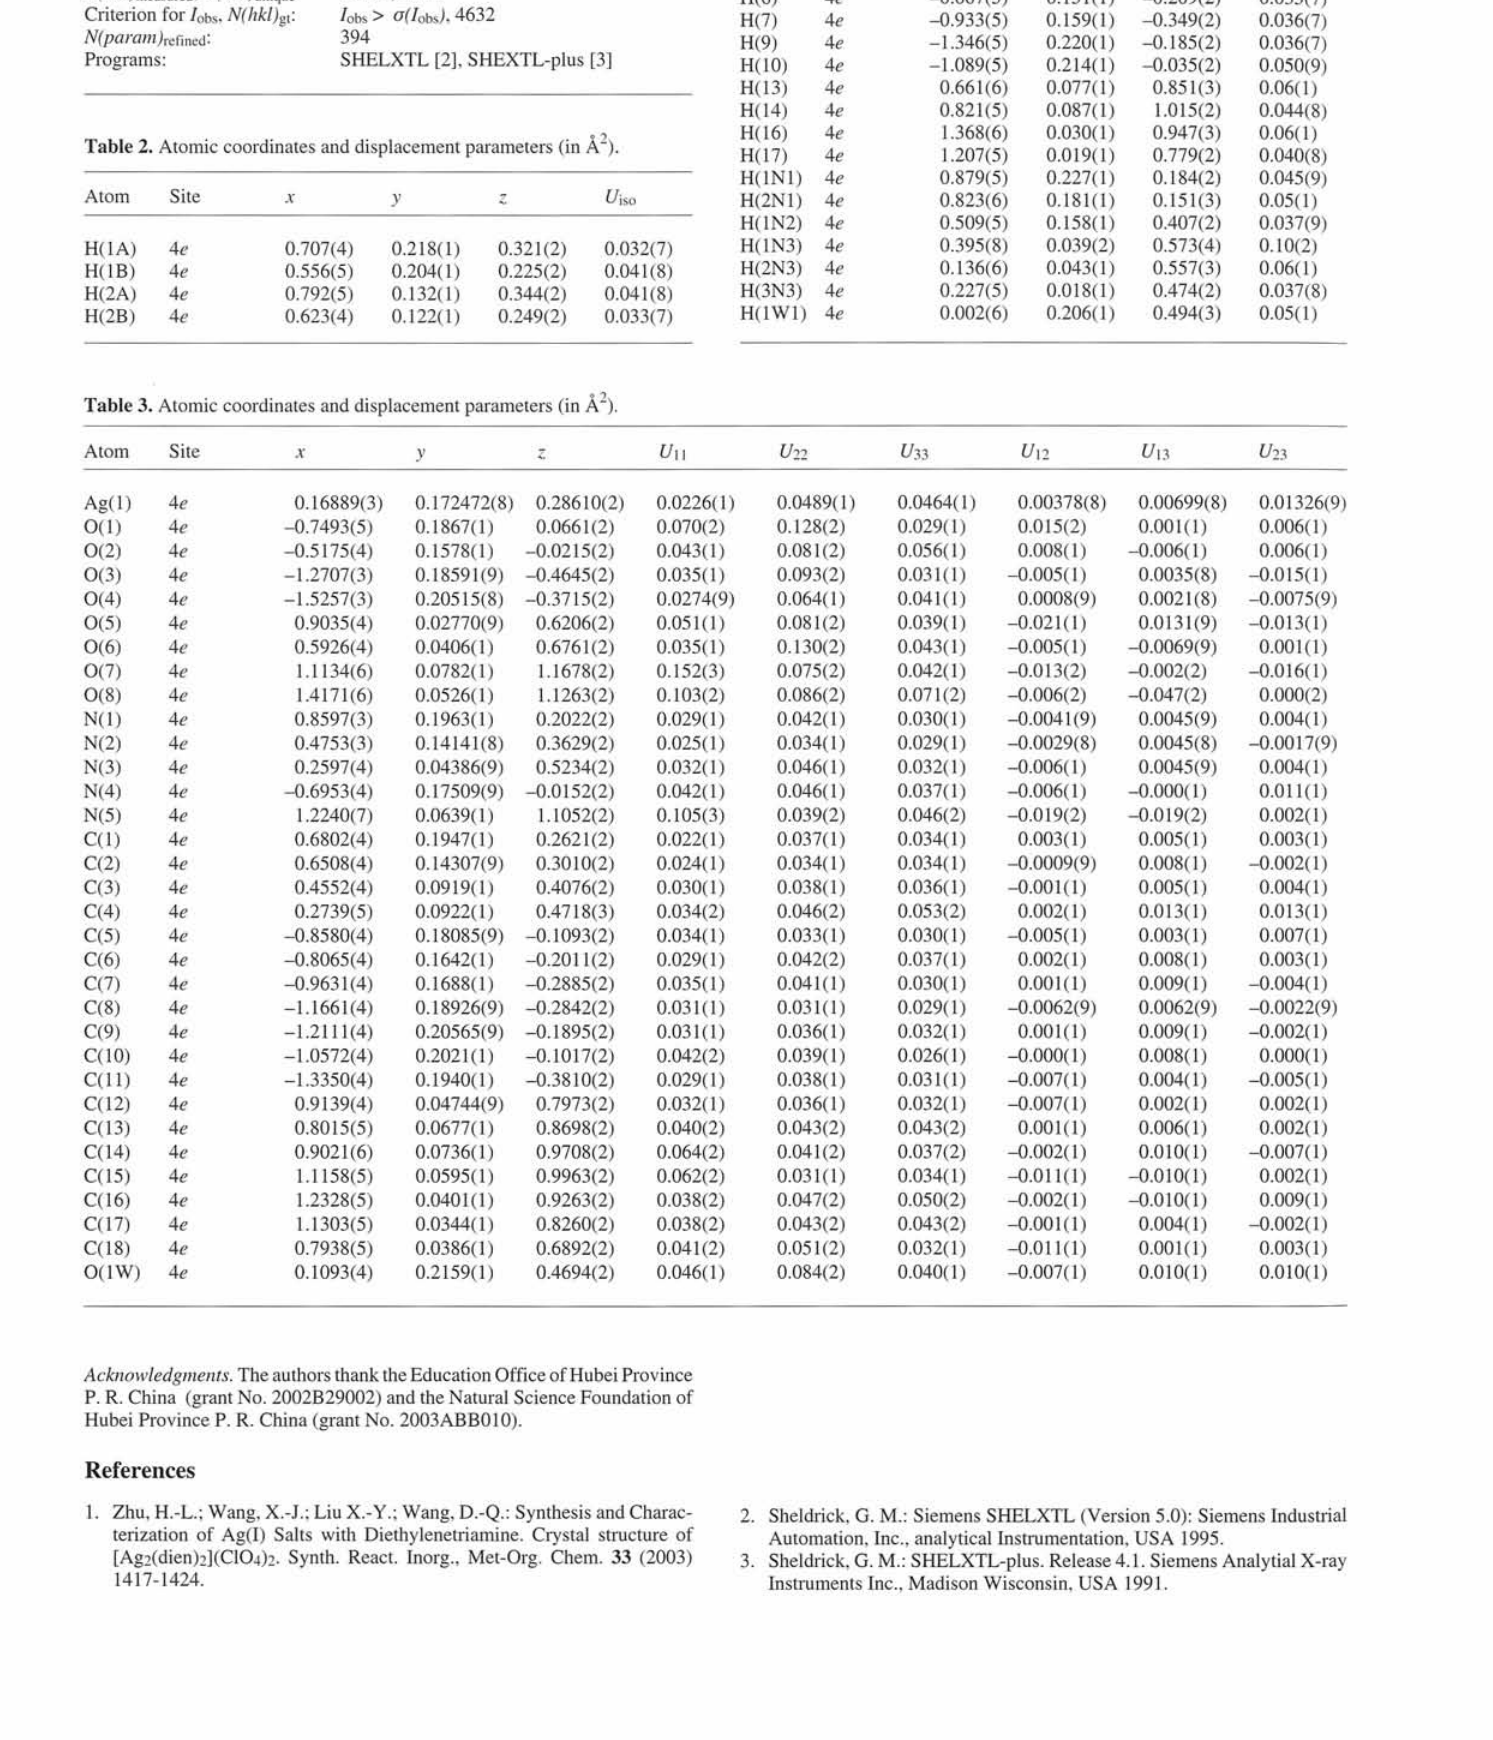
Table 2. Atomic coordinates and displacement parameters (in Â").